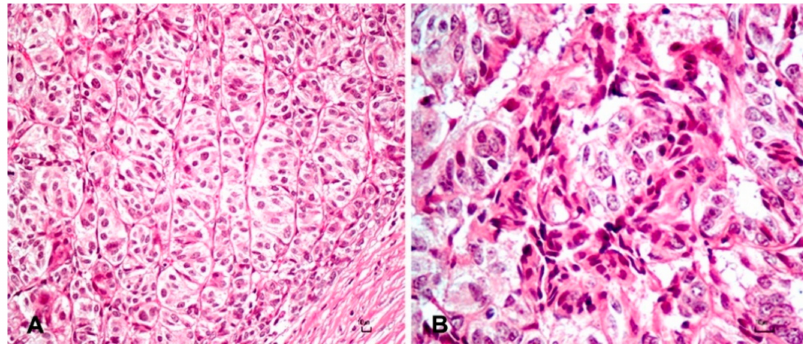
Figure 3. ( A ) Columns and trabeculae of basaloid epithelial cells of the trichoblastoma. Hematoxylin and eosin (H&E). Bar 10 µ m. ( B ) Foci of mesenchymal cells closely associated with neoplastic epithelial cells resembling papillary mesenchymal bodies. H&E. Bar 10 µ m.